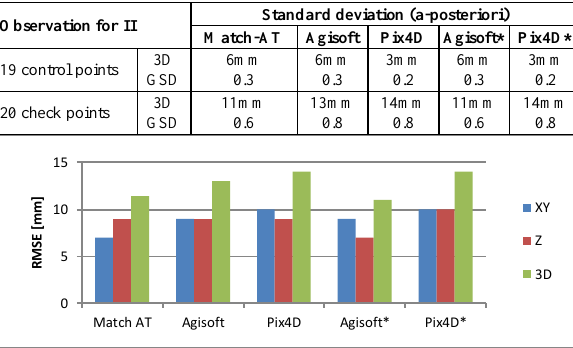
Figure 13: RMSE results at 20 check points (configuration II)